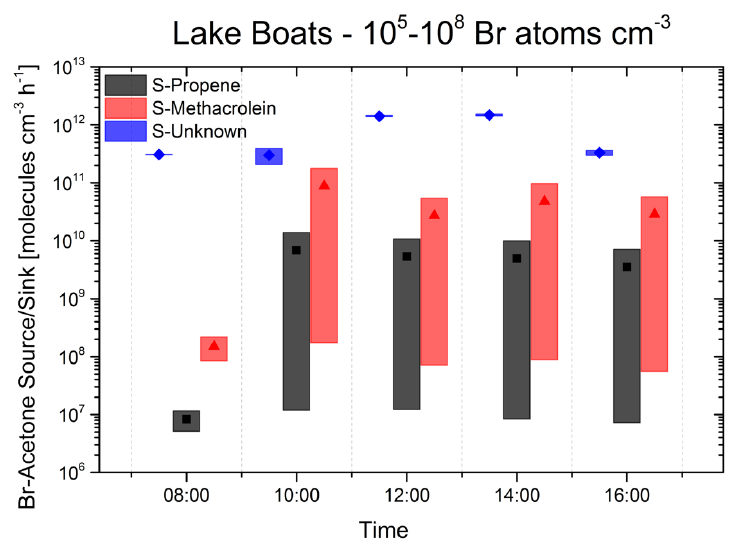
Figure 4. Amount of bromoacetone molecules derived from atmospheric reactions of measured propene (black) and methacrolein (red). Additional bromoacetone molecules, that are necessary for receiving the measured MR in the chamber, are shown in blue and represent an unknown source.